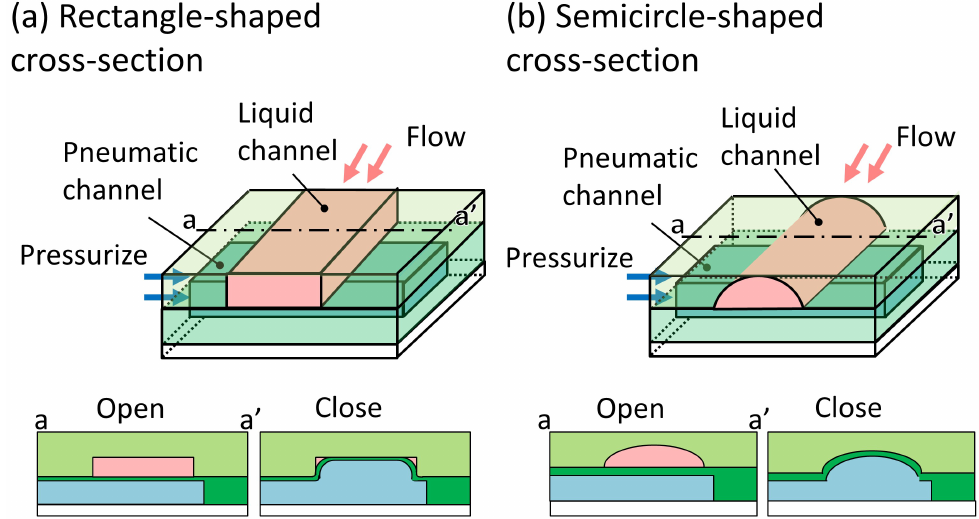
Figure 1. Conventional cross sections of microchannels of pneumatic pressure-driven microvalves. ( a ) Rectangle-shaped cross-section; ( b ) semicircle-shaped cross-section